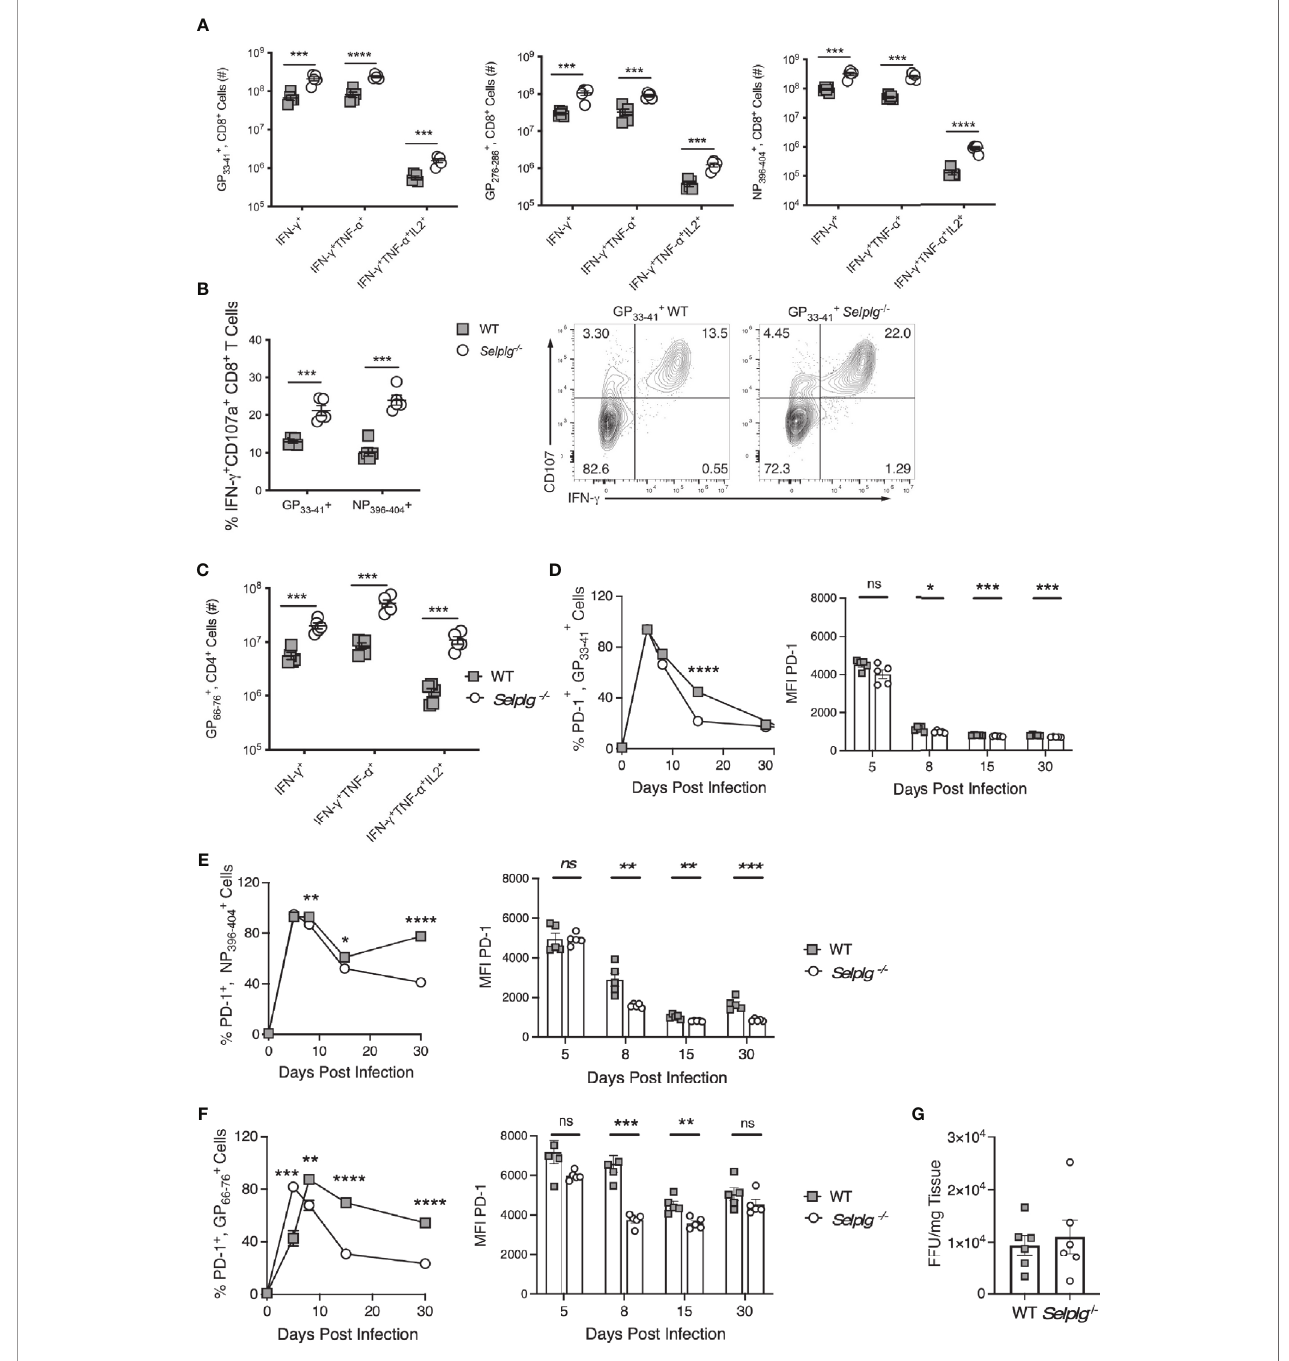
FIGURE 4 | Virus-speci fi c T cells in Selplg -/- mice have increased effector function and altered PD-1 expression. WT and Selplg -/- mice were infected with LCMV Arm and their spleens isolated at 8dpi. Splenocytes were stimulated ex vivo with the indicated LCMV peptides and assessed for the (A) and the numbers of cytokine + CD8 + T cells (B) and the frequencies of IFN- g + CD107a + CD8 + T cells, (C) in addition to the numbers of cytokine + CD4 + T cells. (D, E) % PD-1 + tetramer + , CD8 + T cells and expression of PD-1(MFI). (F) % PD-1 + tetramer + , CD4 + T cells and expression of PD-1 (MFI). (G) Virus titers measured from the spleens at 4dpi by focus forming units (FFU) and expressed/g of tissue. Data in (A – F) are representative of three independent experiments (n = 5 or more mice/group). Data in (G) are from one experiment. Graphs show the mean ± SEM * p < 0.05, ** p < 0.005, *** p < 0.001, **** p < 0.0001 by two-tailed unpaired t-